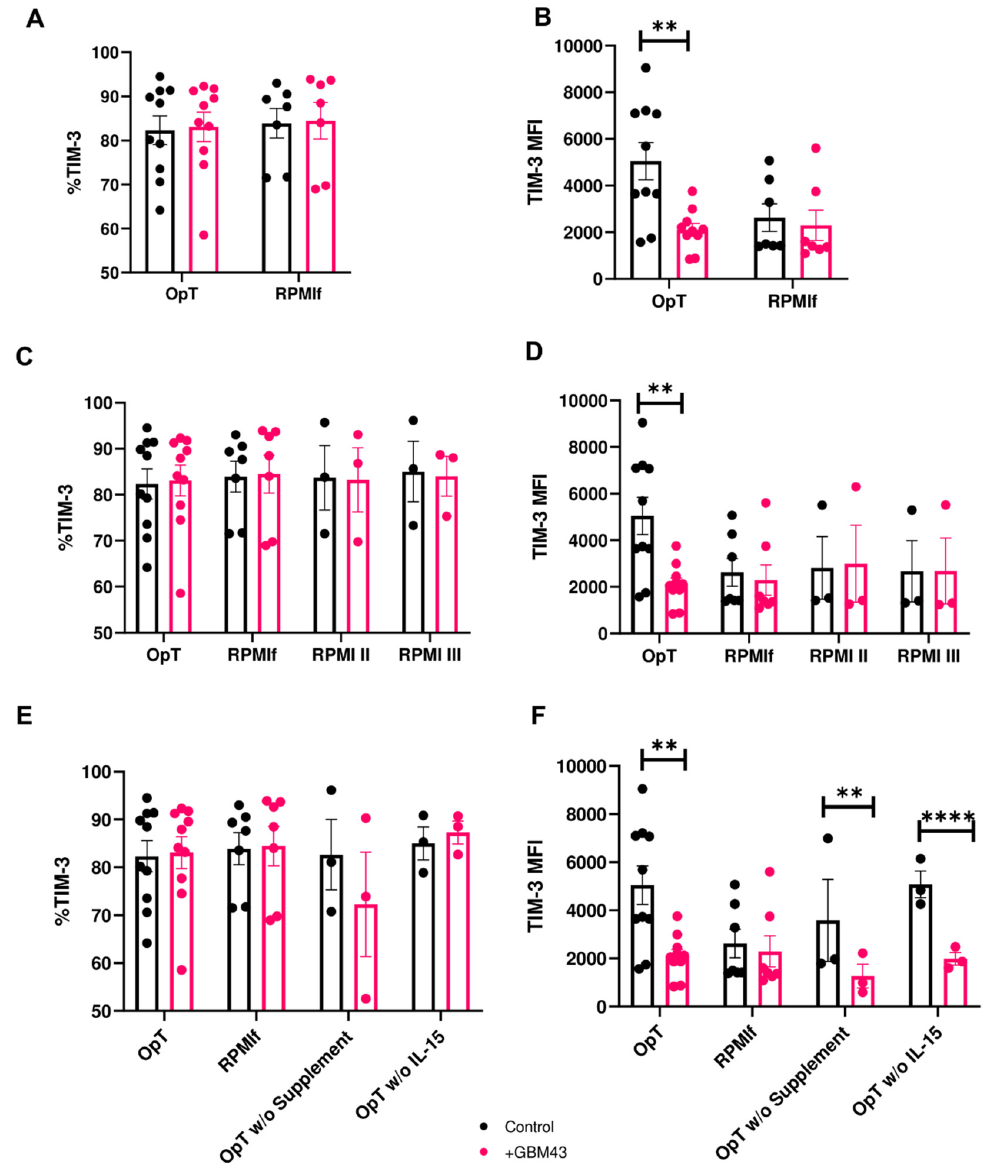
Figure 3. Expression of TIM-3 on NK cells in response to cancer cells under varying stimulation conditions of cytokine and supplement compositions (mean ± SEM). Percentage and MFI of TIM-3 were measured on human NK cells after 4 h co-culture with GBM43 cells at an E:T ratio of 2.5:1. ( A , B ) TIM-3 expression on NK cells expanded in complete NK-modified OpTmizer ™ (OpT) ( n = 10 donors) or RPMI-based expansion medium (RPMIf, n = 7); ( C , D ) TIM-3 expression on NK cells expanded in OpT, RPMIf, RPMI medium modified to contain 10 ng / mL rhIL-15 and 25 ng / mL rhIL-21 (RPMI II, n = 3) or RPMI medium modified to contain 10 ng / mL rhIL-15 (RPMI III, n = 3); ( E , F ) TIM-3 expression on NK cells expanded in OpTmizer ™ (OpT), RPMIf, OpT medium without supplement (OpT w / o supplement, n = 3), or OpT without IL-15 (OpT w / o IL-15, n = 3). ** p < 0.01, **** p <